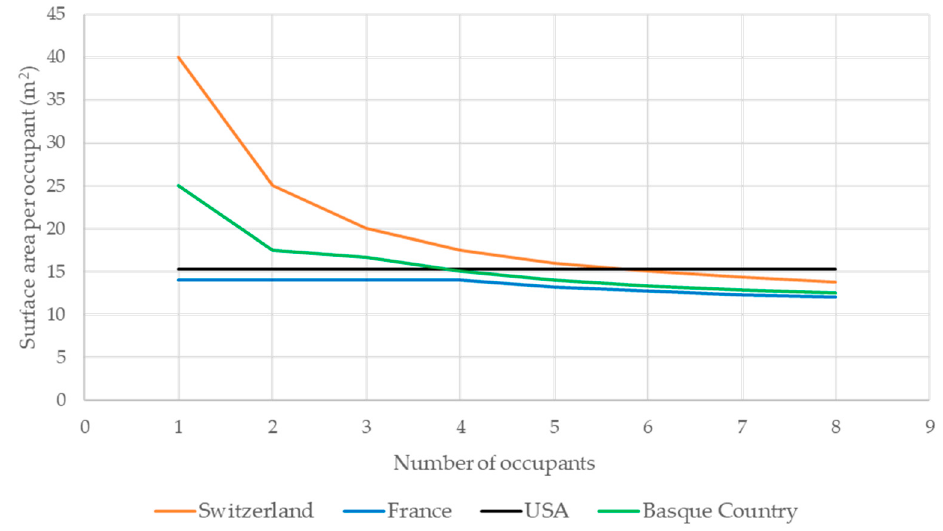
Figure 5. Comparative graph of minimum surface area per inhabitant in the analysed standards.